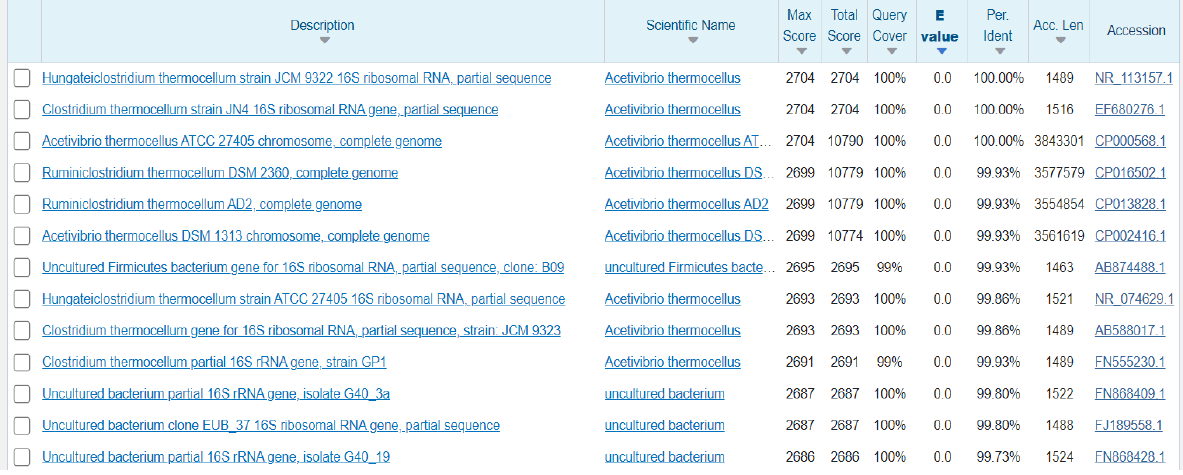
Figure 2. 16SrDNA sequence source and database registration number.